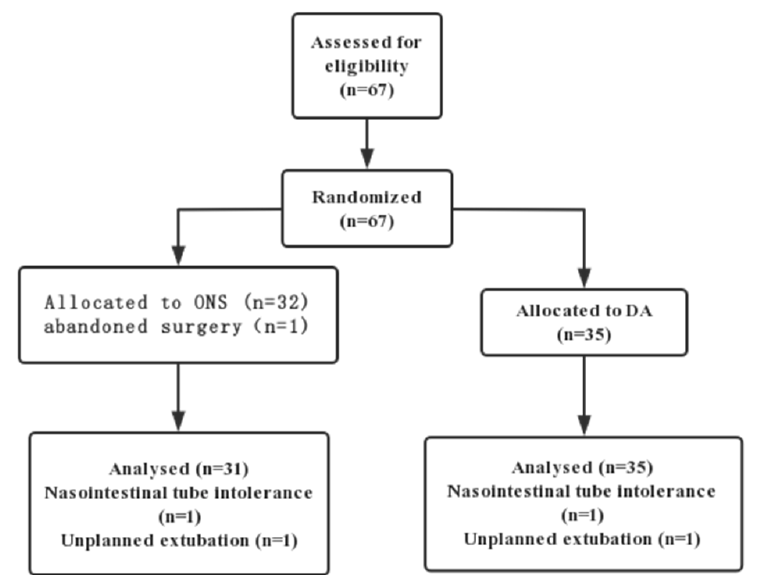
Figure 1. CONSORT flow diagram of patient recruitment and randomization. The findings of early tube feeding are shown in Table 2. There were no significant differences in the incidence of FI (25.8% vs. 31.4%, p = 0.615), the 50% energy compliance rate on POD 5 (54.8% vs. 48.6%, p = 0.611) or the postoperative average tube feeding amount (2260 ± 982 mL vs. 2365 ± 934 mL, p = 0.657). The incidence of postoperative gastrointestinal symptoms (GIS) in the ONS group and DA group was 58.1% and 68.6% ( p = 0.436), respectively, without statistical significance. The major intolerance symptoms were abdominal distention (ONS vs. DA: 45.2% vs. 62.9%, p =0.150) and abdominal pain (ONS vs. DA: 29% vs. 45.7%, p =0.163). Enteral feeding intolerance mainly occurred approximately 3 days after surgery (ONS vs. DA: 2.95 ± 1 vs. 2.93 ± 0.8, p = 0.943).